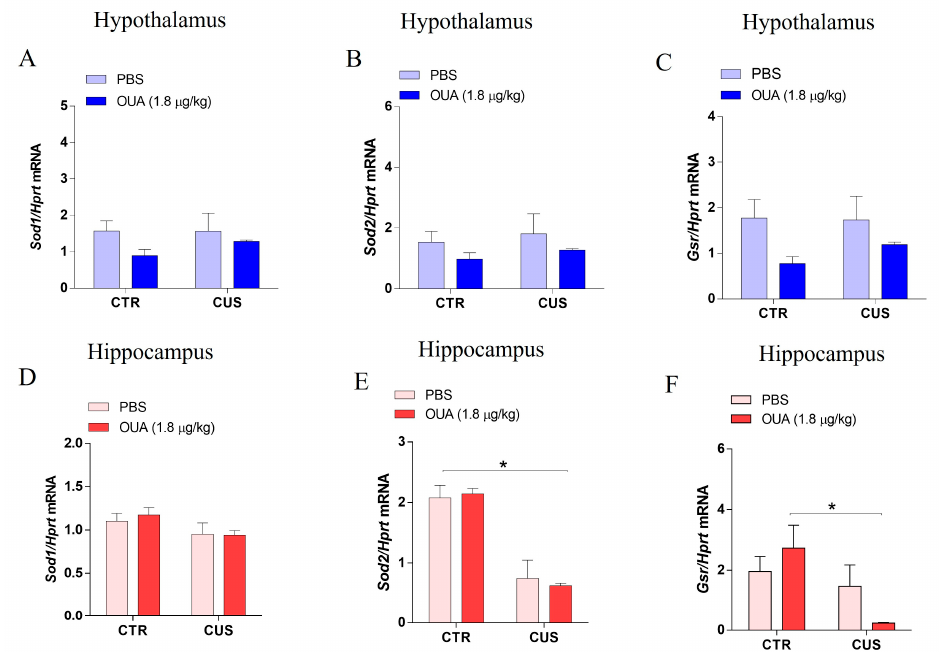
Figure 5. Modulation of antioxidant enzyme expression in rat hippocampus and hypothalamus by CUS protocol. ( A – C ) The results show no alteration in the expression of SOD1 (F (1, 34) = 0.4205; p = 0.5211 for CUS factor. F (1, 34) = 2.601; p = 0.1161 for treatment factor), SOD2 (F (1, 34) = 0.5226; p = 0.4747 for CUS factor. F (1, 34) = 1.922; p = 0.1746 for treatment factor), and GSR (F (1, 32) = 0.3697; p = 0.5475 for CUS factor. F (1, 32) = 6.277; p = 0.0175 for treatment factor) in the hypothalamus of the different groups studied (blue bars) ( n = 8–10). ( D ) The results suggest an absence of modulation in SOD1 (F (1, 34) = 4.067; p = 0.0517 for CUS factor. F (1, 34) = 0.1041; p = 0.7489 for treatment factor) p < 0.0001 for CUS factor. F (1, 34) = 0.01967; p = 0.8893 for treatment factor), * p < 0.001,